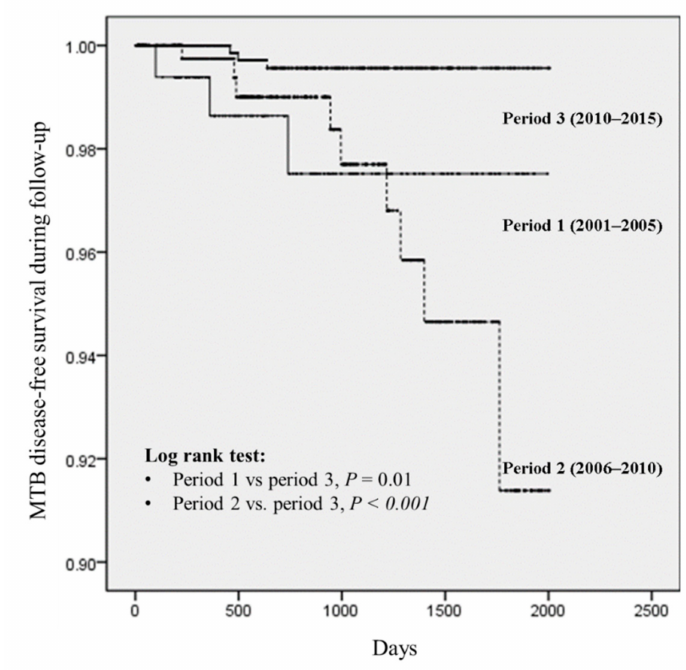
Figure 2. Cumulative Mycobacterium tuberculosis (MTB)-free survival among patients newly diagnosed with HIV, stratified according to the three study periods. The curves demonstrate poorer MTB-free survival among patients in periods 2 and 1 compared with those in period 3 (log-rank test, p = 0.01 and p < 0.001,